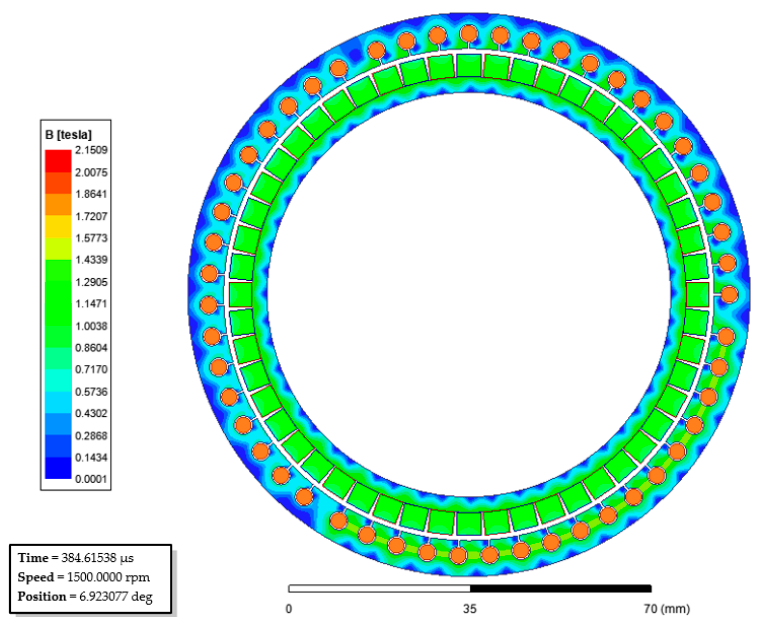
Figure 20. Flux density distribution in the active parts of the Motor.